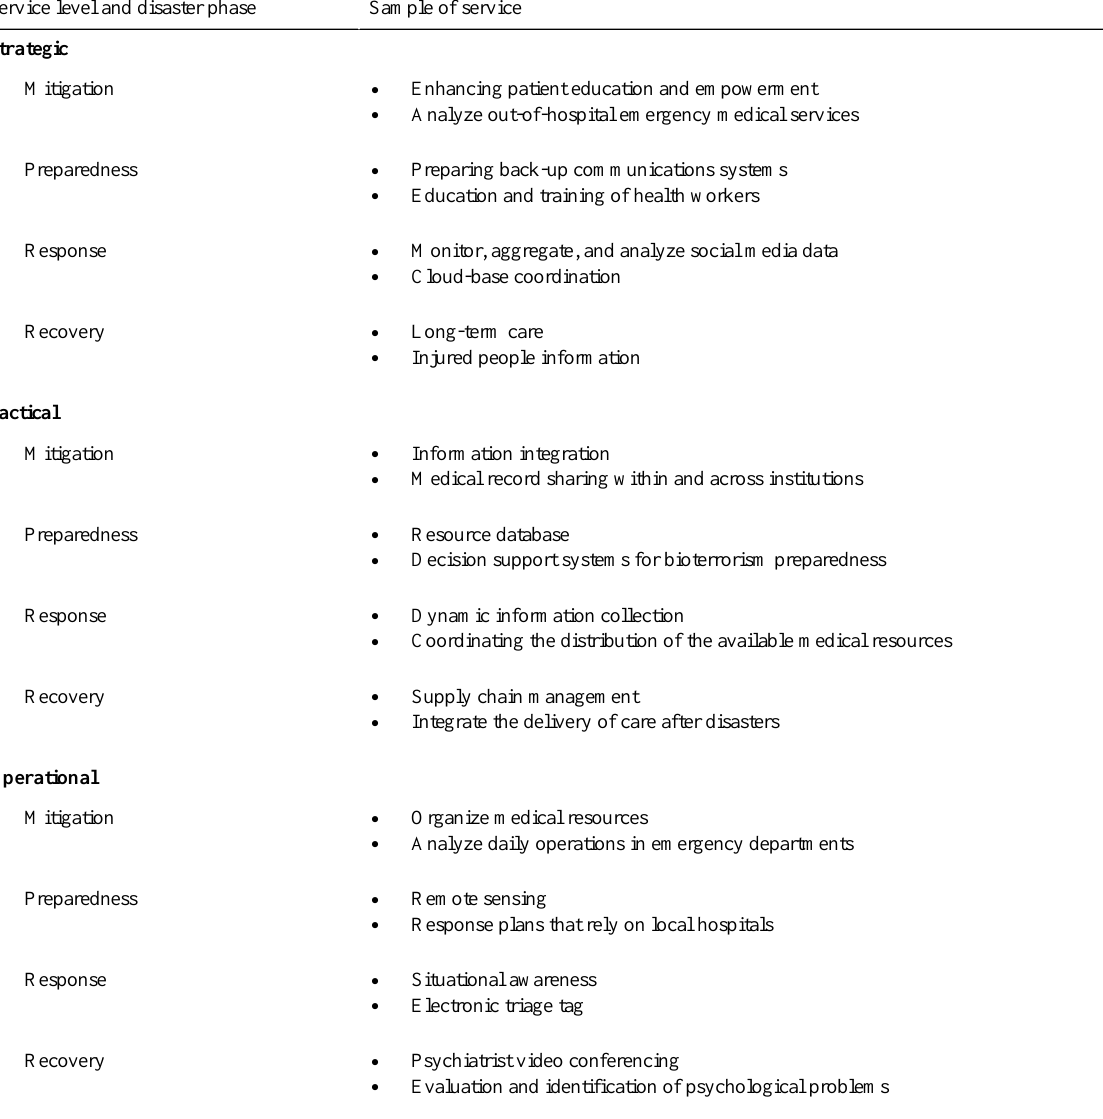
Table 3. Disaster eHealth service level